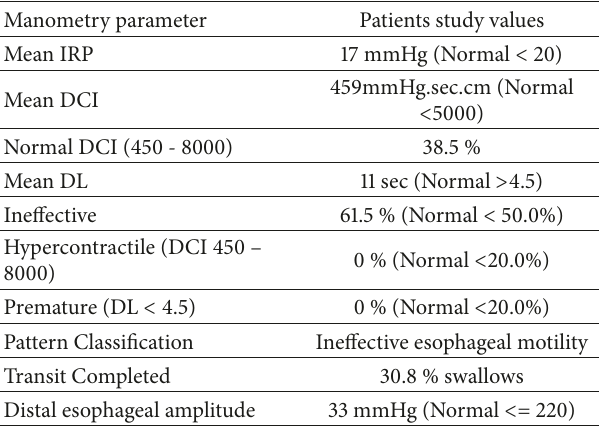
Table 2: Manometry findings consistent with ineffective esophageal